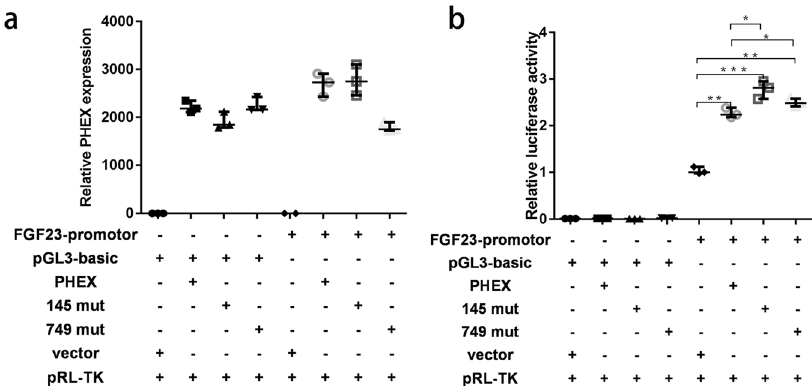
Fig. 5 PHEX regulates the FGF23 promoter. a RT-qPCR was used to detect the expression of PHEX in each group in HEK293T cells. Under the condition that the internal reference β -actin is relatively consistent among each group, the mRNA concentration in the PHEX overexpression group was signi fi cantly increased. b The double luciferase reporter gene method was used to detect FGF23 promoter activity. With Renilla luciferase as the internal reference, the relative fl uorescence intensity calculation formula = fi re fl y luciferase/renilla luciferase. After overexpression of wild-type or mutant PHEX , fi re fl y luciferase activity was enhanced. Mut mutation pRL-TK Ranilla luciferase vector plasmid. (median ± range, n = 3, nonparametric tests, * p < 0.05; ** p < 0.01; *** p <